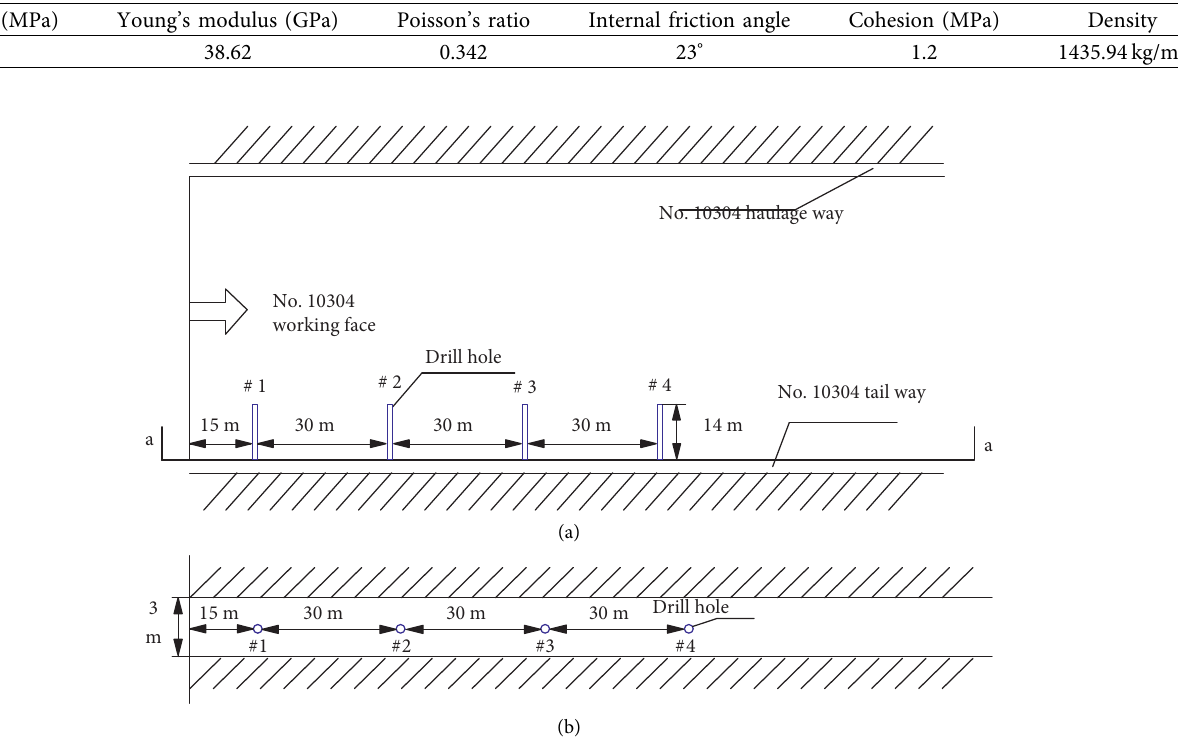
Figure 6: Layout of drilling holes in No. 10304 tail way. (a) Layout plan. (b) Layout section.